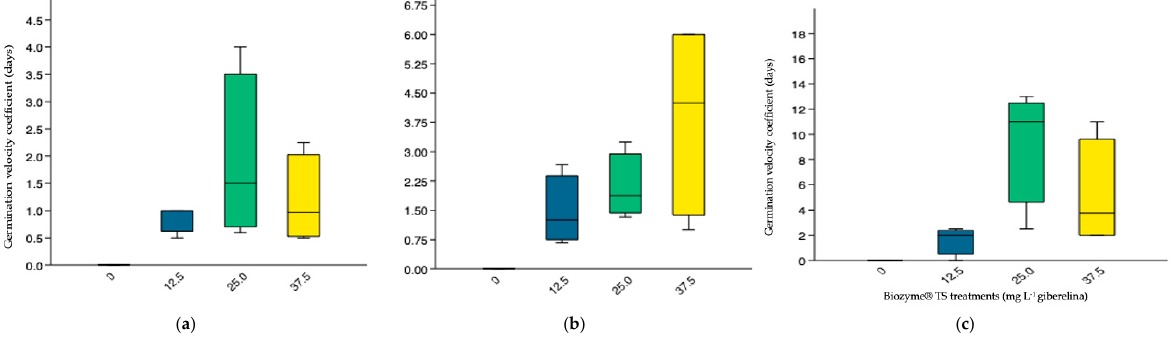
Figure 8. Response of germination velocity coefficient (GVC) to Biozyme ® TS (gibberellins), with: ( a ) 24 h, ( b ) 48 h, and ( c ) 72 h of immersion. Table 6. Comparison of means of germination velocity coefficient (GVC) with 24, 48, and 72 h of immersion in Biozyme ® TS (gibberellins), according to Tukey HSD. I. T., h. Treatm.